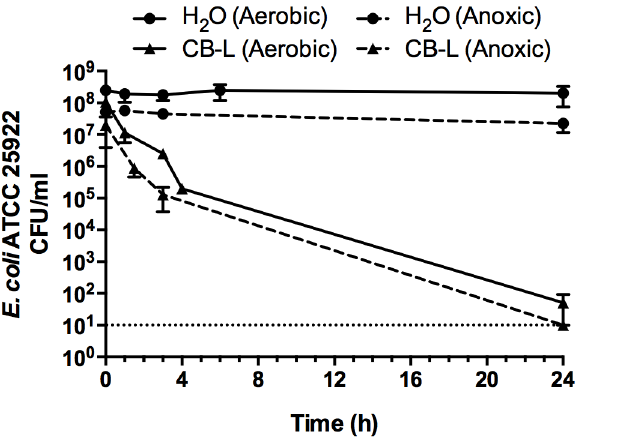
Fig. 7. Assessment of E. coli viability during exposure to CB-L under aerobic and anoxic conditions. Error bars represent the SEM for three independent experiments. The dotted line represents the limit of